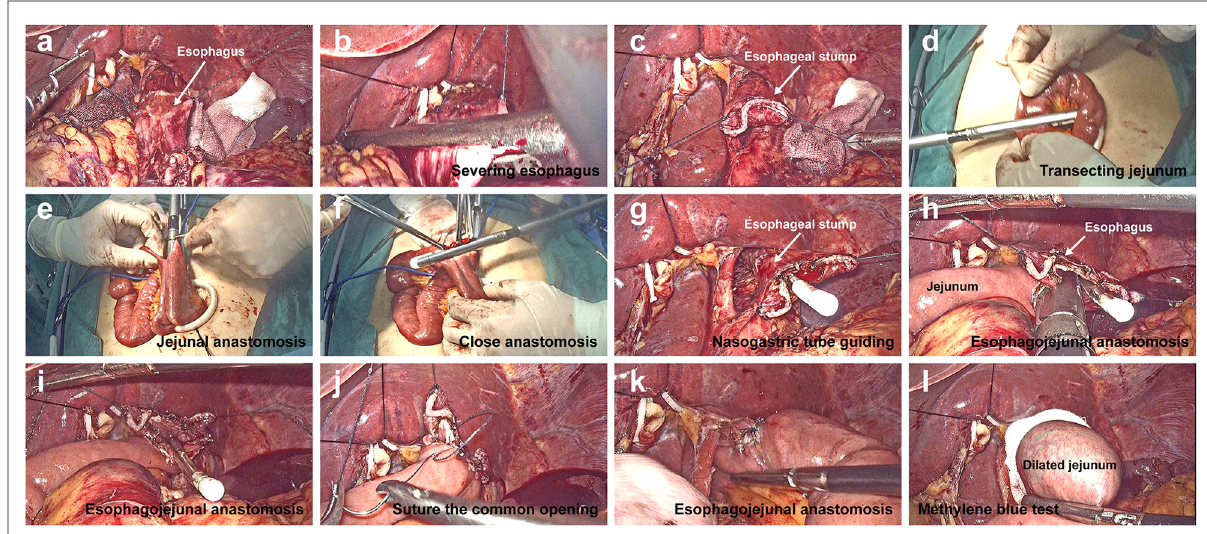
FIGURE 2 Digestive tract reconstruction in single-incision plus one-port laparoscopic gastrectomy (SILG+1). ( A – C ) The left lobe of the liver was overhung using a percutaneous 2-0 nylon purse-string suture and hemolok ligation clip. Suturing was performed via a stitch with a 4-0 barbed line on the left and right sides of the pre-separation esophagus. The esophagus and stomach were transected using a linear stapler. ( D – F ) a side-to-side jejunal anastomosis was created using the stapler between the afferent jejunum and a point 40 cm below the efferent jejunum. ( G ) After opening a hole in the middle of the esophageal stump, the gastric tube was pulled out from the hole to guide the correct lumen. ( H,I ) a side-to-side esophagojejunal anastomosis (Overlap) was performed. ( J,K ) A 4-0 barbed line was used to close the common opening, and another 4-0 barbed line was used to reinforce the anastomotic stoma by suturing the seromuscular layer. ( L ) Methylthionine chloride was injected through the gastric tube to detect the integrity of the